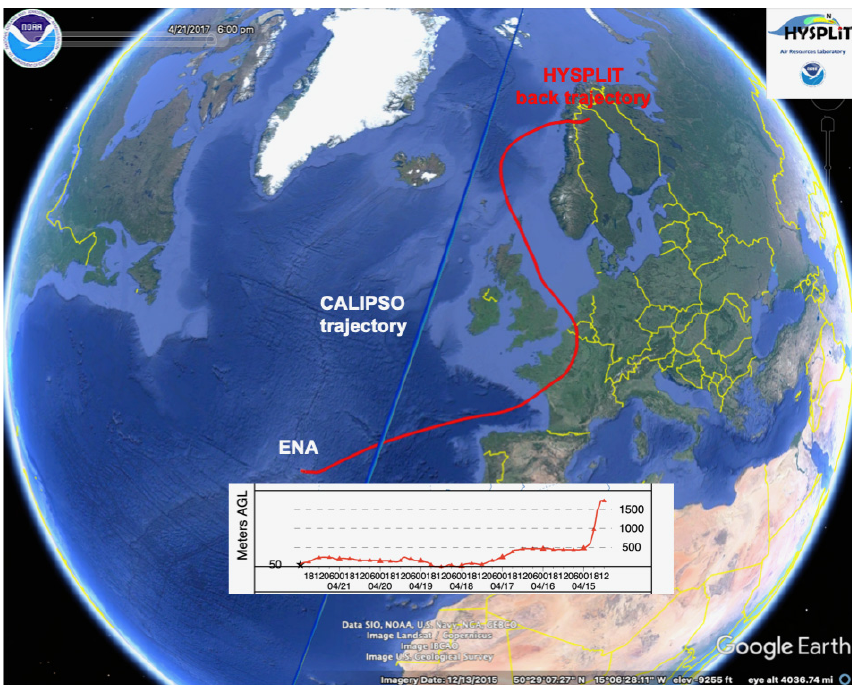
Figure 5. CALIPSO trajectories (blue) and HYSPLIT back trajectories (red) arriving at 50ma.g.l. above the ENA site on 21 April 2017 (© Google Earth